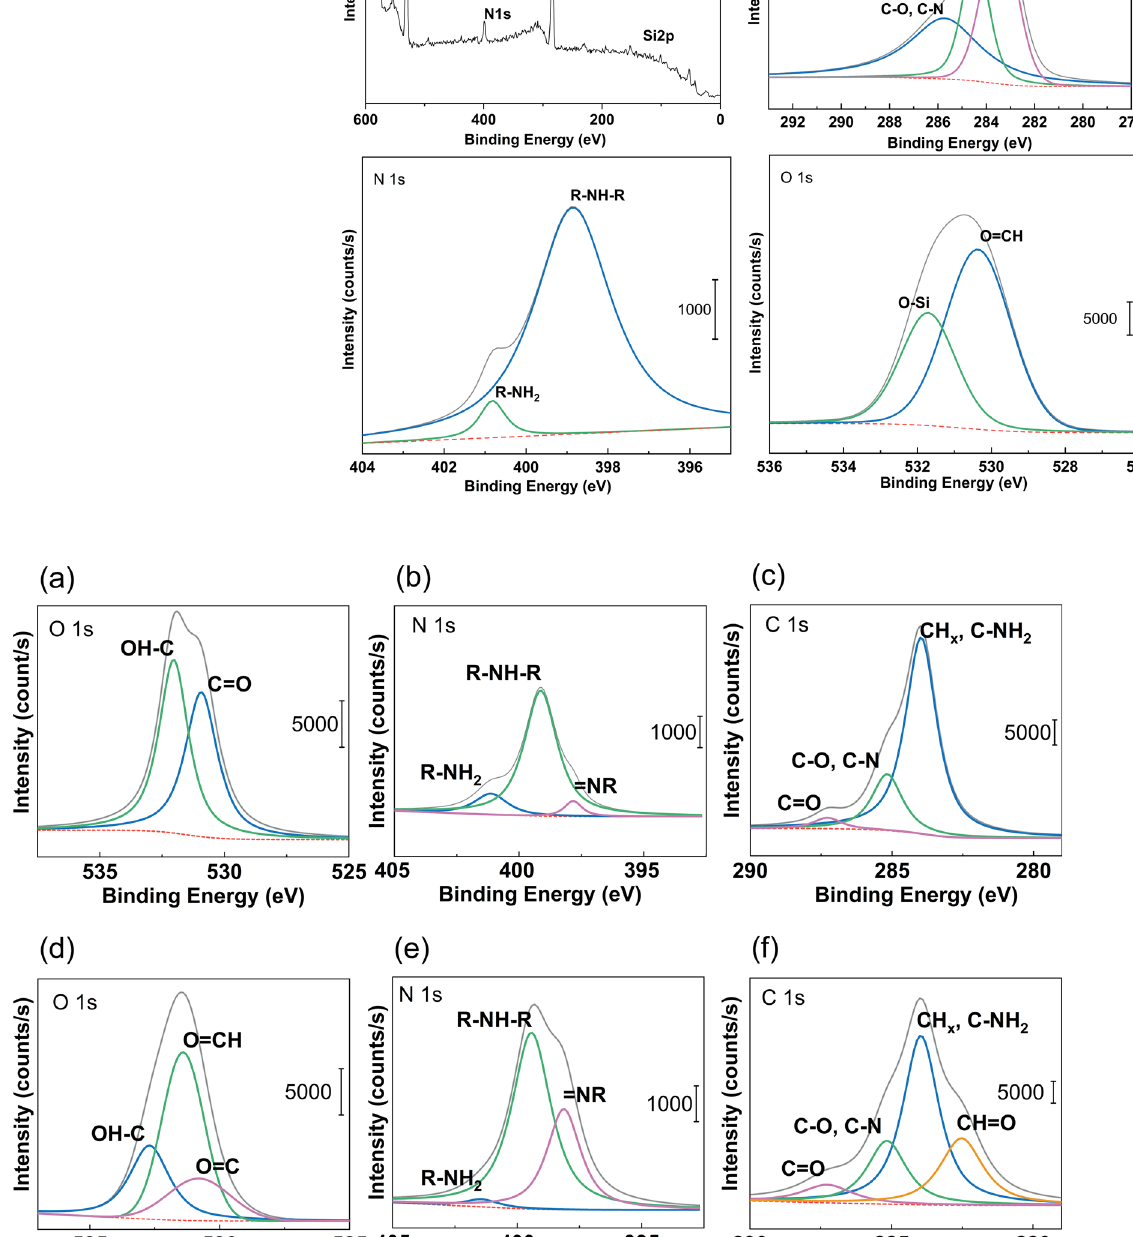
Fig. 3 Binding energies of ( a ) O1s, ( c ) N1s, ( e ) C1s on the pristine-PDA surface and ( b ) O1s, ( d ) N1s, ( f ) C1s on the